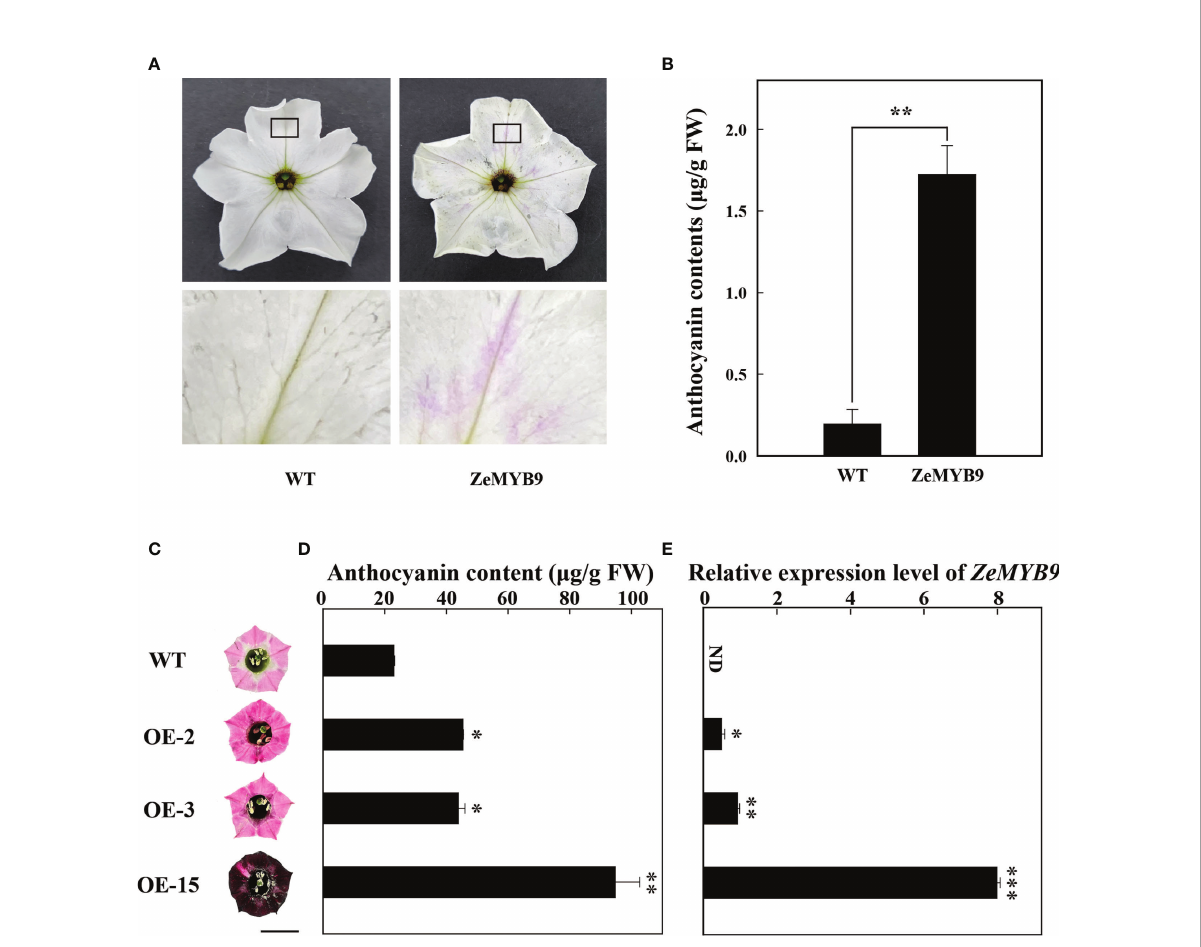
FIGURE 4 Overexpression of ZeMYB9 in petunia and tobacco. (A) Phenotype of the entire (above) and the partial view (below) of petal limbs in wild type and ZeMYB9 -overexpression fl owers. (B) Total anthocyanin content in petal limbs of wild type and transiently transformed petunia. (C) Petal limb phenotype of wild-type and transgenic tobacco plants (OE-2, OE-3 and OE-15). The black line on the diagram showed a scale of 1cm. (D) Total anthocyanin contents in wild type and transgenic tobacco petal limbs. (E) Transcription levels of ZeMYB9 in wild type and transgenic tobacco petal limbs. Data were showed as the mean ± SE from three biological replicates. T-test was used for statistical analyses compared with corresponding control (*P < 0.05, **P < 0.01, ***P <